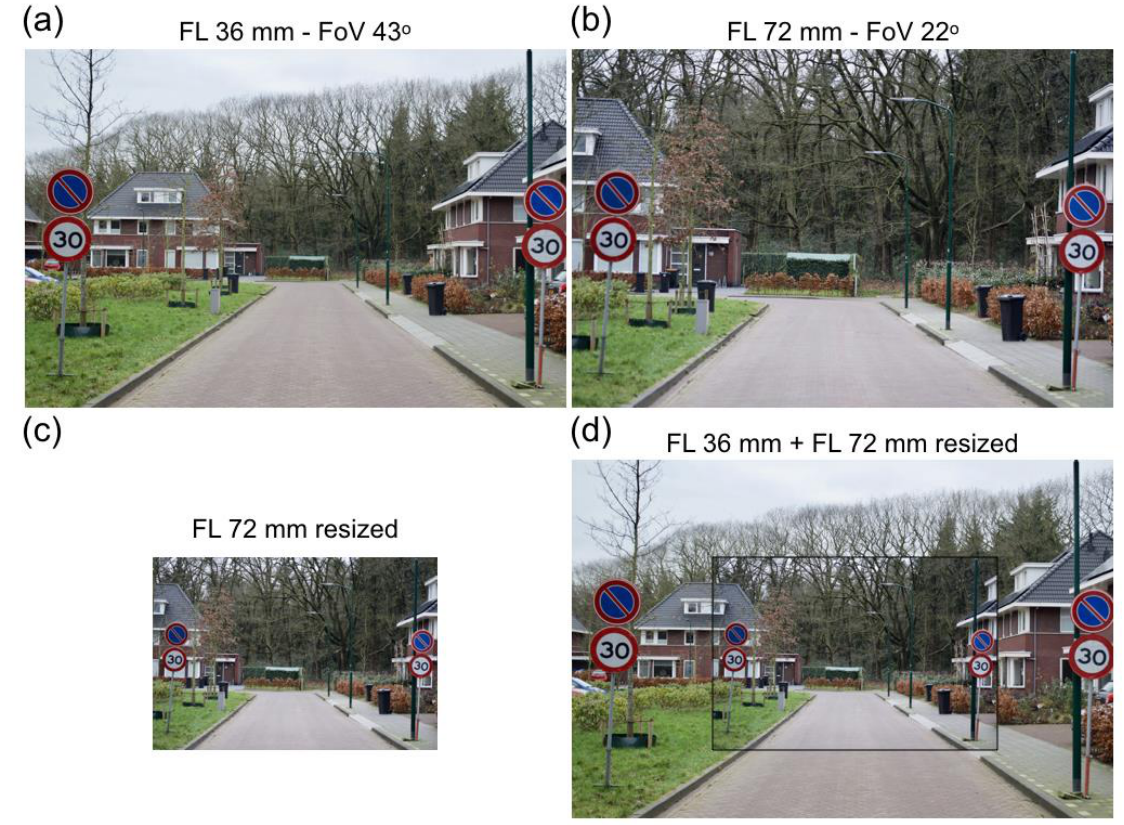
Figure 1. Two pictures of the same perspective scene. ( a ) The picture was taken with a camera equipped with a lens having a focal length (FL) of 36 mm and a field of view (FoV) of 43°. ( b ) The picture was taken with another lens (FL 72 mm, FoV 22°) from another camera position. ( c ) The picture is a resized version of Figure ( b ). The house on the left side is scaled to that of Figure ( a ). ( d ) Figure ( c ) including a thin black rim is placed on top of Figure ( a ).